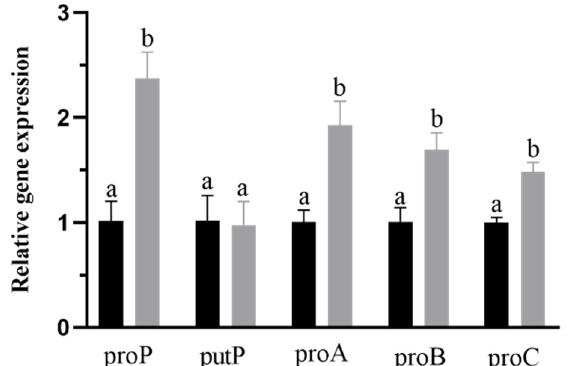
Figure 5. Relative quantitation of genes related to proline synthesis and transport. The black column represents the group of common osmotic pressure cultivation, and the gray column represents the group of higher osmotic pressure cultivation. Columns with different letters indicate significant differences ( p < 0.05).